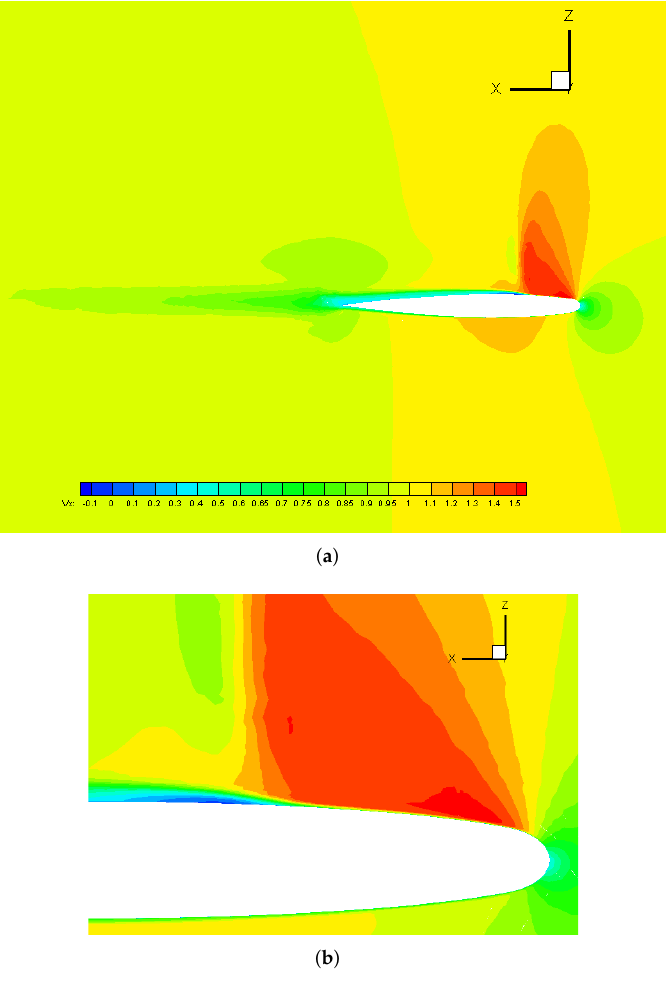
Figure 11. Iso-contours of streamwise velocity in Menter SST at y / ( b /2 ) = 0.9 ( a ) and zoom over the leading edge ( b ) in the ONERA M6 wing at α = 3.06 ◦ (flow from right to